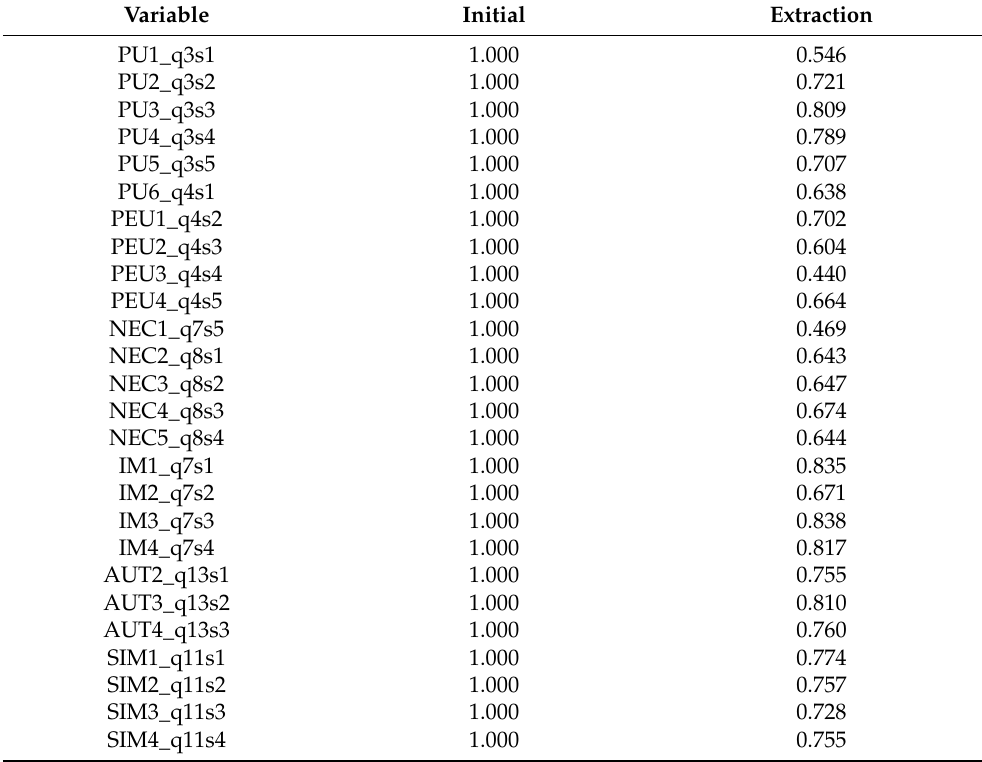
Table 3. Extracted communalities during Exploratory Factor Analysis *.